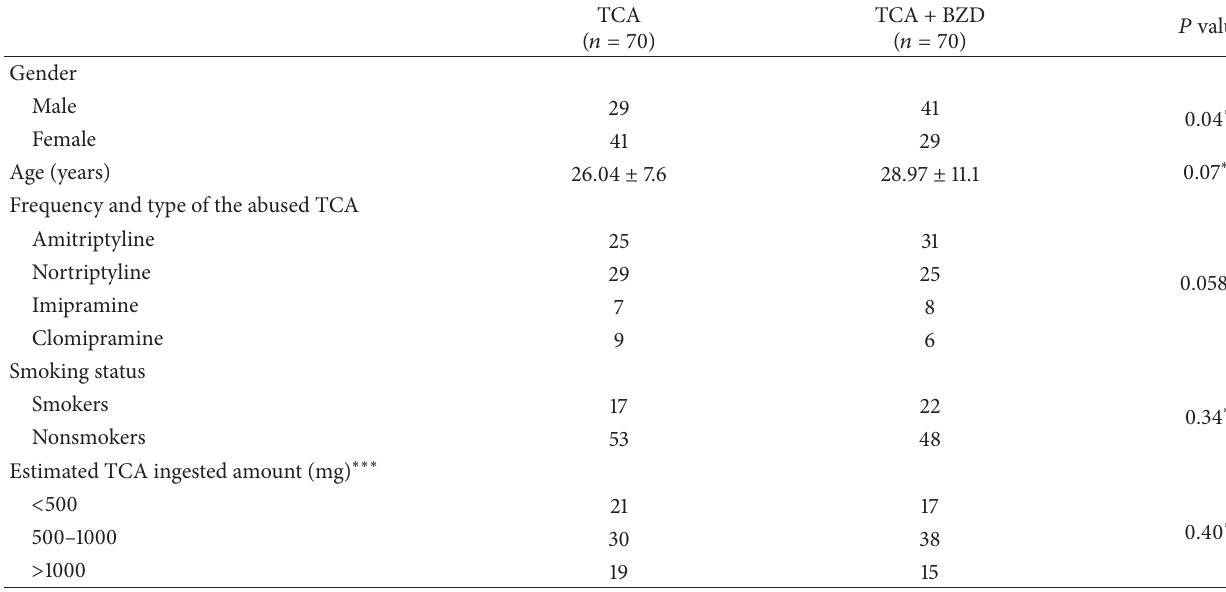
Table 1: Demographic data of the studied patients in TCA only and TCA plus benzodiazepine ingestion groups.